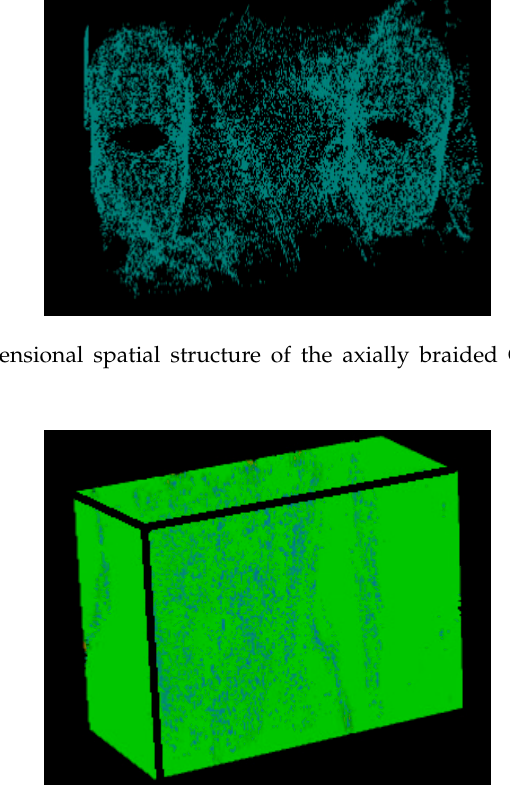
Figure 13. Three-dimensional structure of axially braided C/C composite matrix charcoal by Micro- CT.